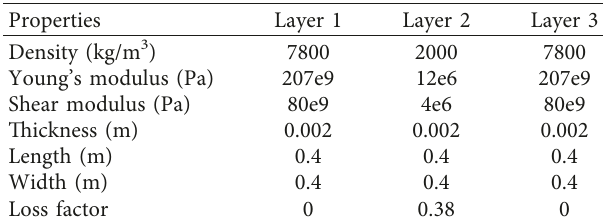
Figure 2: Analysis of DOF for the proposed new plate finite element for multilayer plate. (a) Proposed new plate finite element for multilayer plate. (b) Analysis of DOF for each node for multilayer Table 1: Plate parameters for validation.